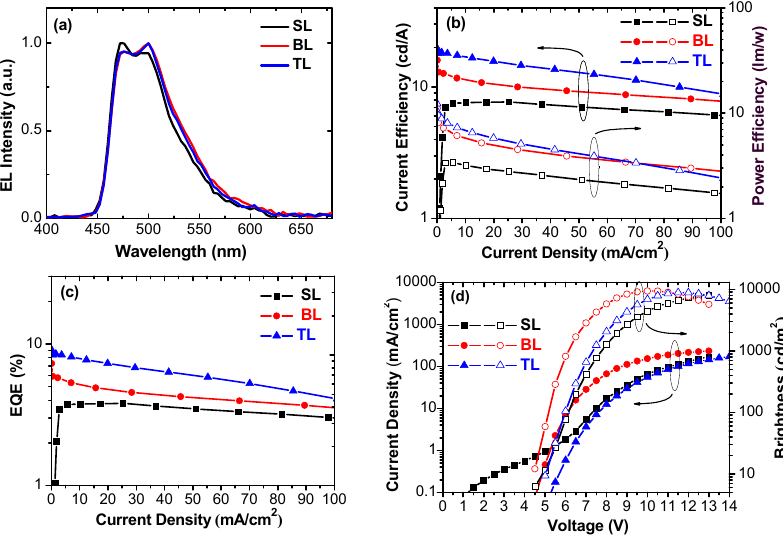
Figure 6. Electroluminescence characteristics of SimCP3- hosted FIrpic OLEDs. ( a ) EL spectra at ~10 volt; ( b ) Current density dependent current efficiency and power efficiency; ( c ) Current density dependent external quantum efficiency; ( d ) Voltage dependent current density and brightness. Table 1. Electroluminescence characteristics of SimCP3- hosted FIrpic OLEDs